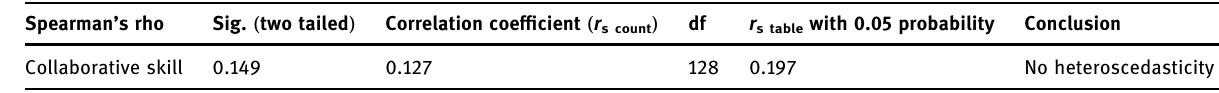
Table 6: The Summary of heteroscedasticity test Spearman ’ s rho Sig. ( two tailed